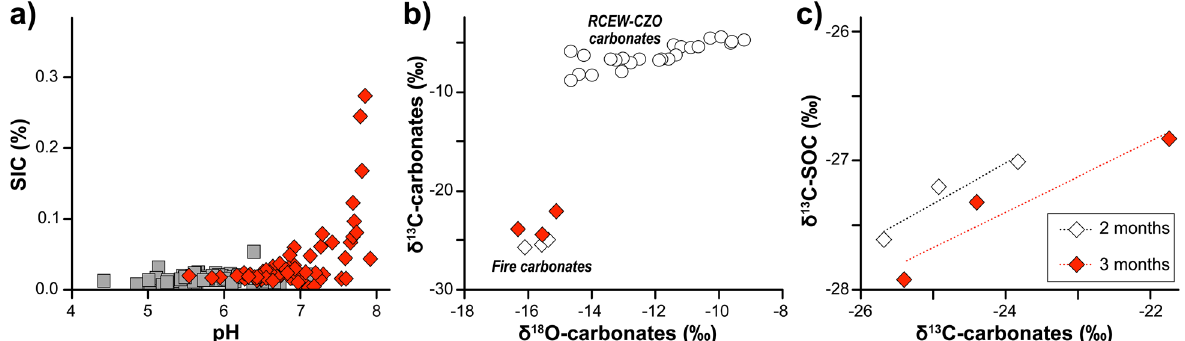
Figure 4. Soil pH and carbonate isotopes values provide possible mechanisms for SIC formation. ( a ) A threshold associated with soil inorganic carbon (SIC) formation was observed as pH increases following fire, burn soils (red), control (grey), ( b ) Plot of δ 13 C- and δ 18 O-carbonate values depicting depleted fire carbonate isotope ratios relative to observed soil carbonates at depth in the RCEW-CZO, and ( c ) the correlation of δ 13 C- carbonate values with δ 13 C-SOC